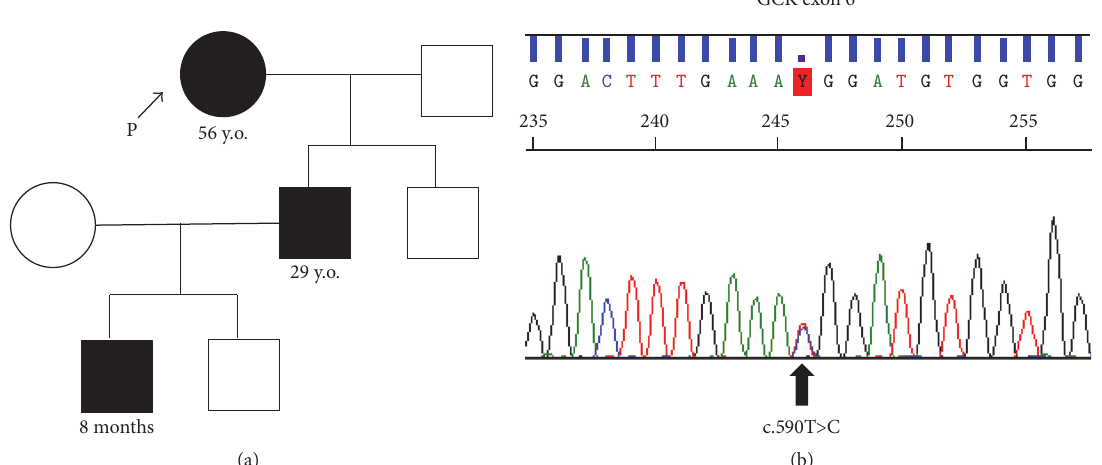
Figure 1: (a) Pedigree tree of the patient. (b) GCK gene analysis of the patient (grandmother). The heterozygosity of exon 6 c.590T > C (p.M197T), a novel GCK-activating mutation, was